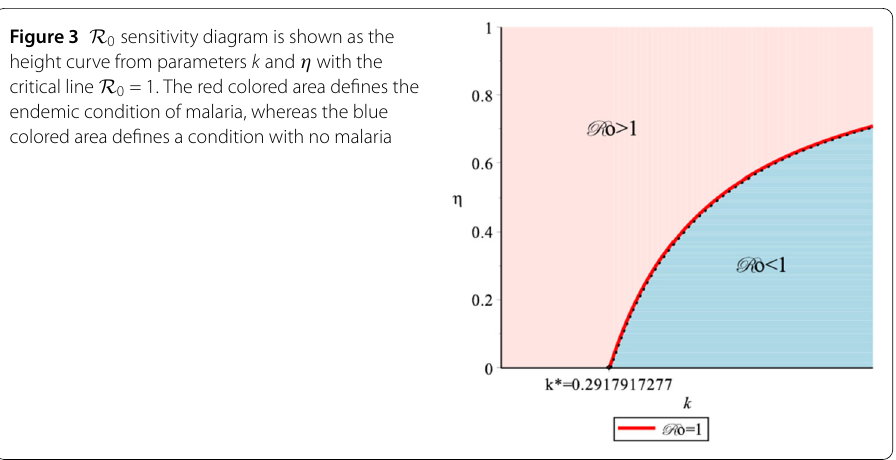
Figure 3 R 0 sensitivity diagram is shown as the height curve from parameters k and η with the critical line R 0 = 1. The red colored area defines the endemic condition of malaria, whereas the blue colored area defines a condition with no